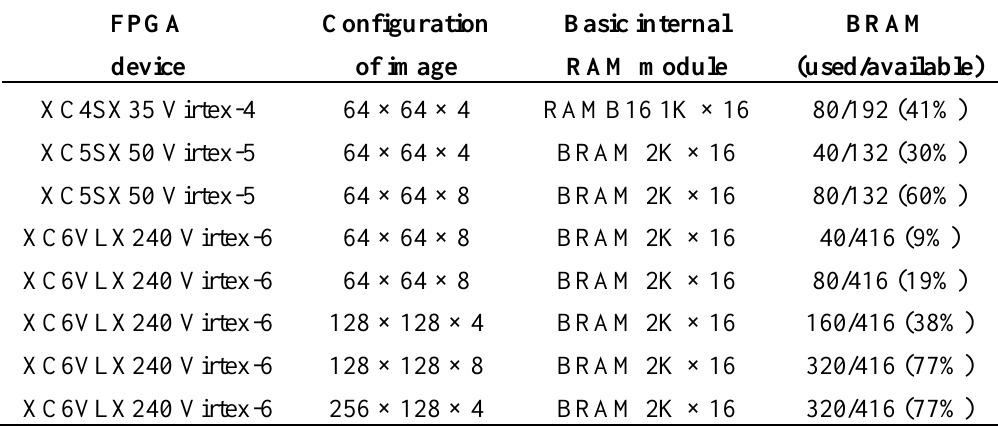
Table 4. FPGA internal memory